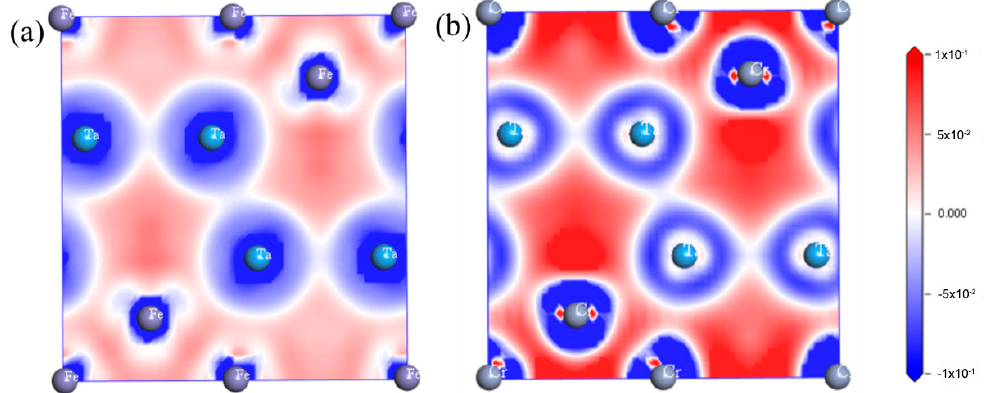
Figure 14. Differential charge density diagrams: ( a ) TaFe2; ( b ) TaCr2.